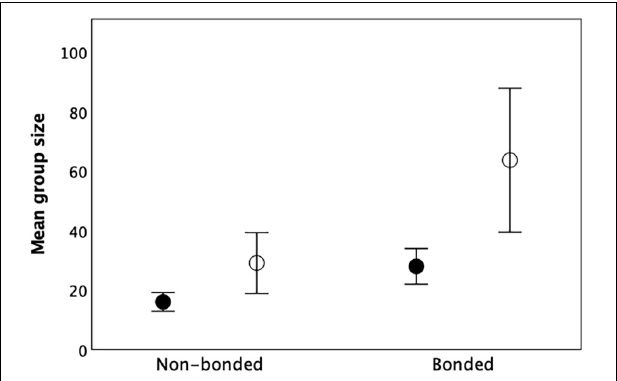
FIGURE 10 | Mean ( ± 1se) group size for 26 primate genera as a function of whether the genus has bonded or unbonded social groups and whether (unfilled symbols) or not (filled symbols) these groups have fission-fusion capability. Source: Supplementary Dataset 5 .